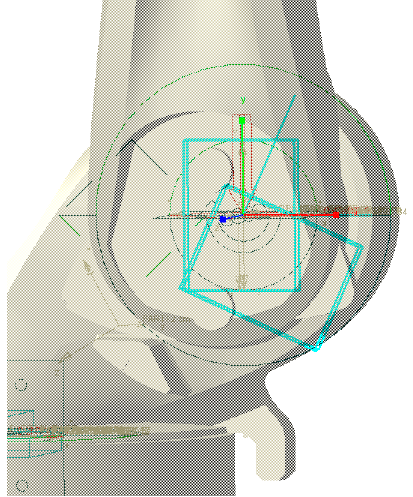
Figure 8. Setting of Adams ‐ based joint constraints.